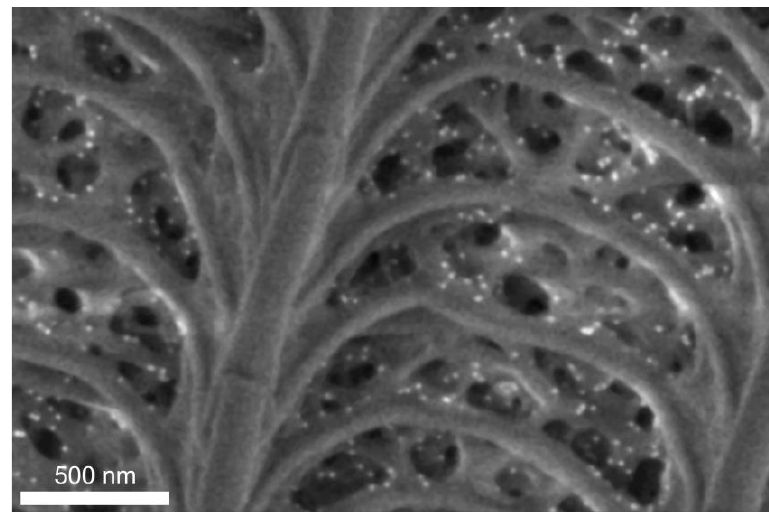
Figure 5. Scanning electron micrograph of a scale of the Polyommatus icarus wing after the application of 120 µL of Au NP sol and complete drying. One may note the presence of bright dots in the image, which represent the Au NPs.